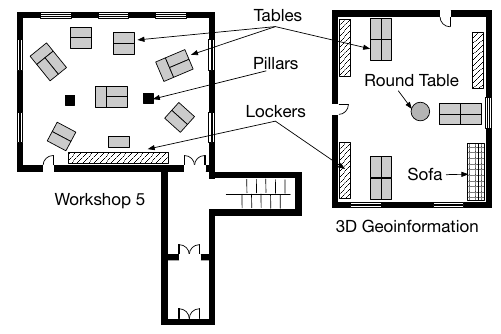
Figure 9. Floor layouts of experiment environments.